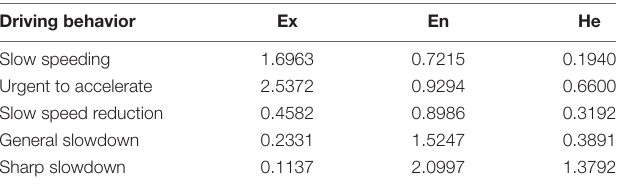
TABLE 4 | Numerical characteristics of comprehensive cloud model integrating the qualitative